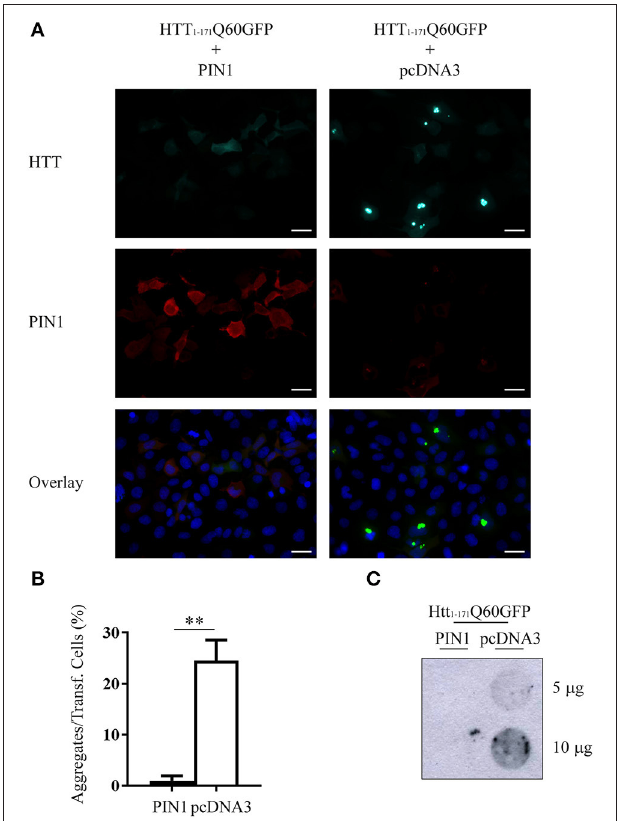
FIGURE 1 | PIN1 overexpression reduces mHTT aggregate number. HEK293 cells were co-transfected with htt 1 – 171 Q60GFP and HA-PIN1 or pcDNA3.0. Cells were harvested for analysis 48h after transfection. (A) Representative immunofluorescent images of co-transfected cells immunostained for PIN1 (anti-HA, red) and counterstained with DAPI (blue). GFP signal (green) represents HTT. Scale bar, 20 µ m. Pictures were captured using a Leica CTR 6000. (B) mHTT aggregate amount quantified from immunostained cells as shown in (A) . (C) Representative filter retardation assay of SDS-insoluble aggregates extracted from co-transfected cells. For data on transfection efficiency and total numbers of cells counted see Supplementary Table 2 column “Figure 1.” Data are the mean ± SEM from 3 independent experiments using 3 different batches of cells. ** P < 0.01. Asterisk indicates the statistically significant difference in the level of aggregates. FIGURE 2 | mHTT aggregate reduction is linked to PIN1 activity.